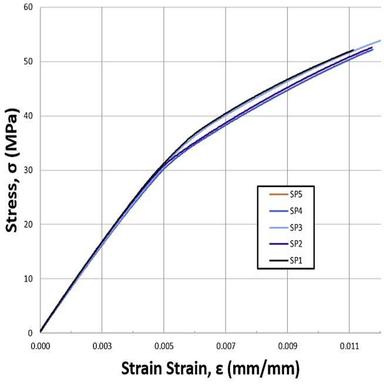
ABS-20GF Stress-Strain Curves.